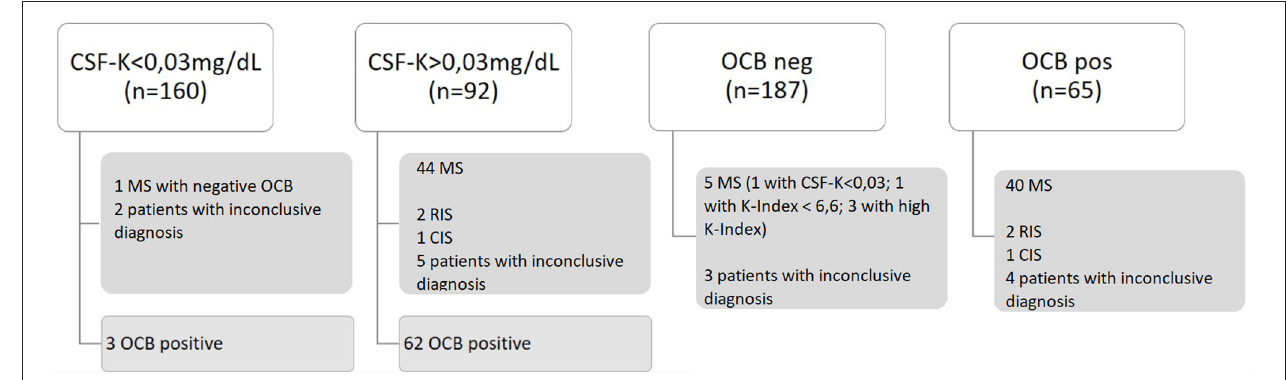
FIGURE 1 | Patient distribution according to detectable ( > 0.03 mg/dl) or undetectable ( < 0.03 mg/dl) K-FLC CSF levels and OCB status positive or negative for the presence of > 2 oligoclonal bands. MS, multiple sclerosis; OCB, oligoclonal banding; RIS, radiologically isolated syndrome; CIS, clinically isolated syndrome; K-FLC, kappa free light chain; CSF, cerebrospinal